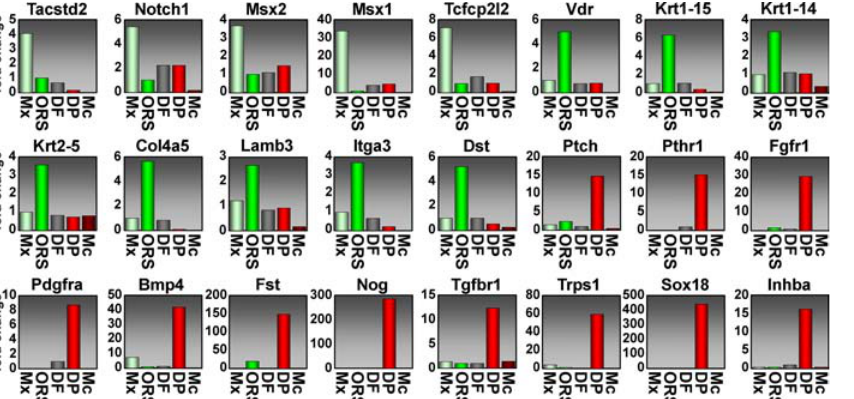
Figure 6. Detailed Expression Analysis of Hair/Skin Disease Genes Found in the Molecular Signatures of the Epithelial and Mesenchymal Populations of the Hair Bulb Real-time PCR confirmation of 24 different signature genes of the Mx, ORS, or DP, which have previously been implicated in genetic disorders of the hair. Many of these genes have not been well-studied at the level of expression and function. In each case, the highest level of mRNA expressed corresponded to the cell population in which the signature gene appeared. Moreover, in cases where more than one cell population showed appreciable mRNA levels, this was also reflected in our microarray comparisons. DOI: